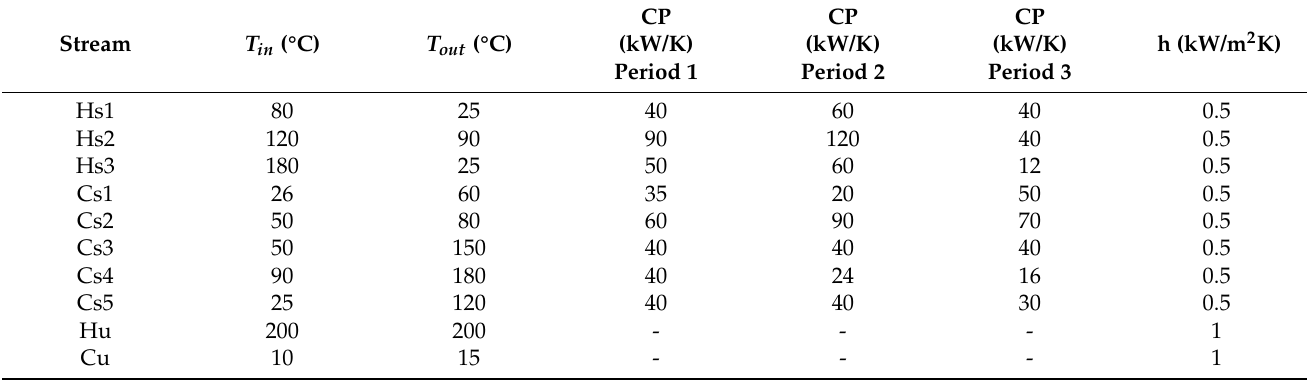
Table 4. Stream data for case